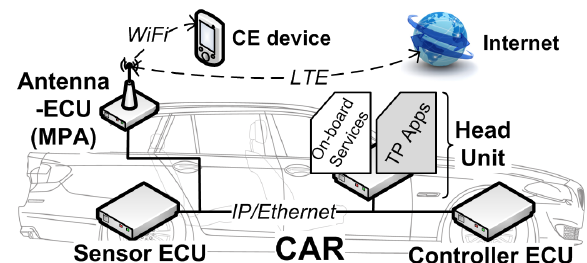
Figure 1. On-board Network Architecture and considered scenarios. Solid right-angle lines represent the wired on-board network. The dashed arrows represent external communications over different wireless